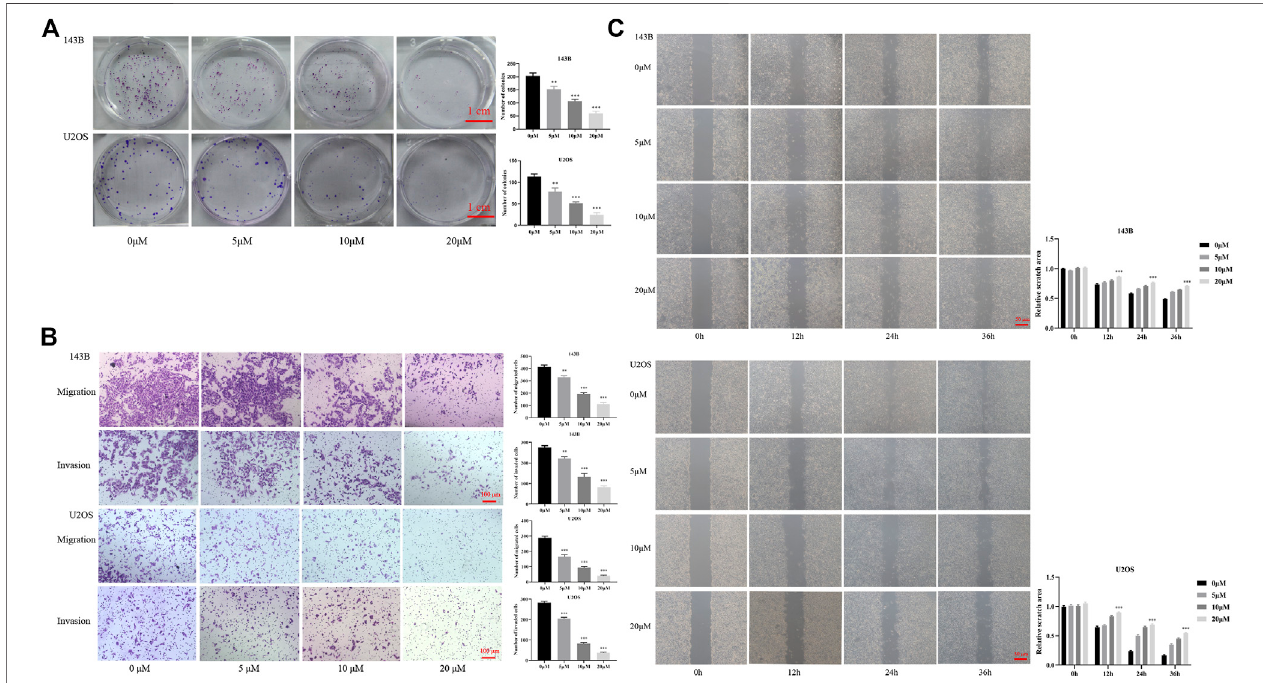
FIGURE2| EffectofCY-09oncellproliferation,migration,andinvasioninosteosarcoma (A) Cellproliferationof143BandU2OScellsdetectedbycolonyformation assay after treatment with different concentrations of CY-09 for seven days (B) Cell migration and invasion of 143B and U2OS cells were examined using the transwell assayaftertreatmentwithdifferentconcentrationsofCY-09 (C) Cellmigrationof143BandU2OScellswasevaluatedusingthewoundhealingassayaftertreatmentwith different concentrations of CY-09 for 0, 12, 24, and 36 h. The experiments were conducted in triplicate.